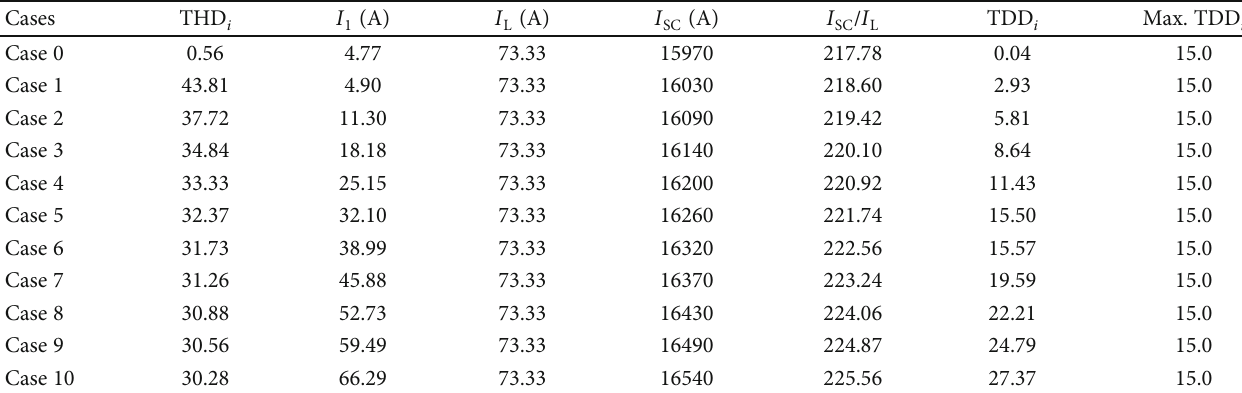
Figure 11: THD under di ff erent cases at PCC. v Table 7: THD and TDD at PCC for di ff erent PV penetration i i